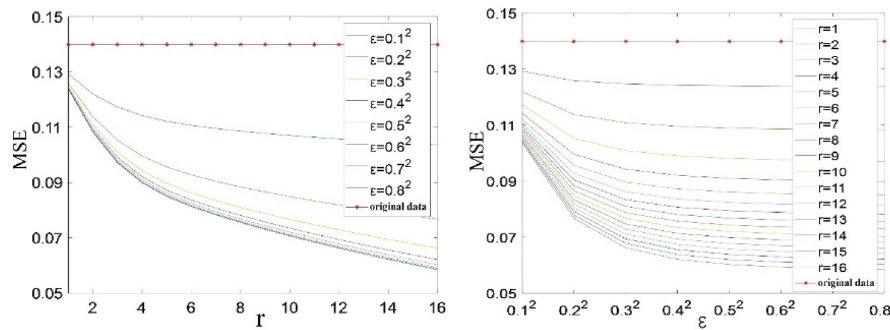
Fig. 1 Mean square error (MSE) of seismic data according to different parameters. a window radius, r , and b regularization parameter,